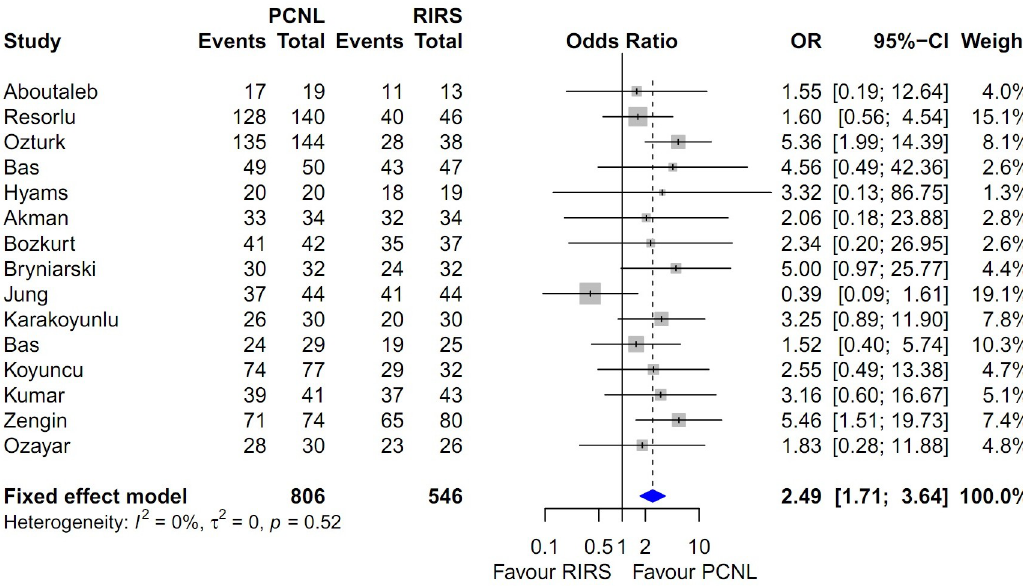
Fig 3. Pairwise meta-analysis of success rate in PCNL and RIRS. Pooled data assessment of stone-free rate between PCNL and RIRS showing a significantly higher stone-free rate with PCNL (OR 2.31; 95% CI 1.45–3.67; P < 0.001).